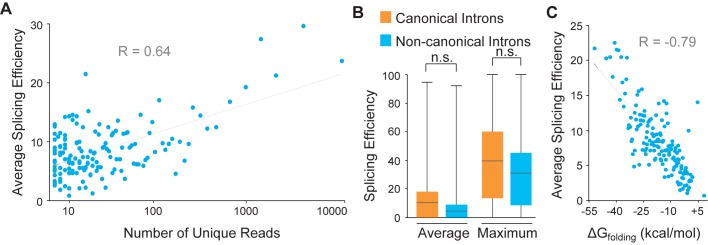
Short introns are both alternatively spliced and structured.(A) Short intron splicing efficiency was calculated for 3,027 predicted short introns. The introns were binned in groups of 20 according to sequencing read support, and splicing efficiency was plotted. There is a positive correlation between sequencing read support and splicing efficiency (R = 0.64, p < 0.01). (B) Short introns were separated according to whether they had canonical or non-canonical sequences at the ends of the introns. Both average and maximal splicing efficiency (across all cell lines) were calculated for every intron. Plotted are the box-and-whisker plots with the highest, lowest, 25th, 50th, and 75th percentiles indicated. There was no significant (n.s.) difference between canonical and non-canonical intron splicing efficiency. (C) The free energy of folding (ΔGfolding) was calculated for every short intron. The introns were ranked by folding energy and binned in groups of 20; average splicing efficiency per group was then calculated. The data are plotted showing a strong negative correlation between folding free energy and splicing efficiency (R = -0.79, p < 0.01).